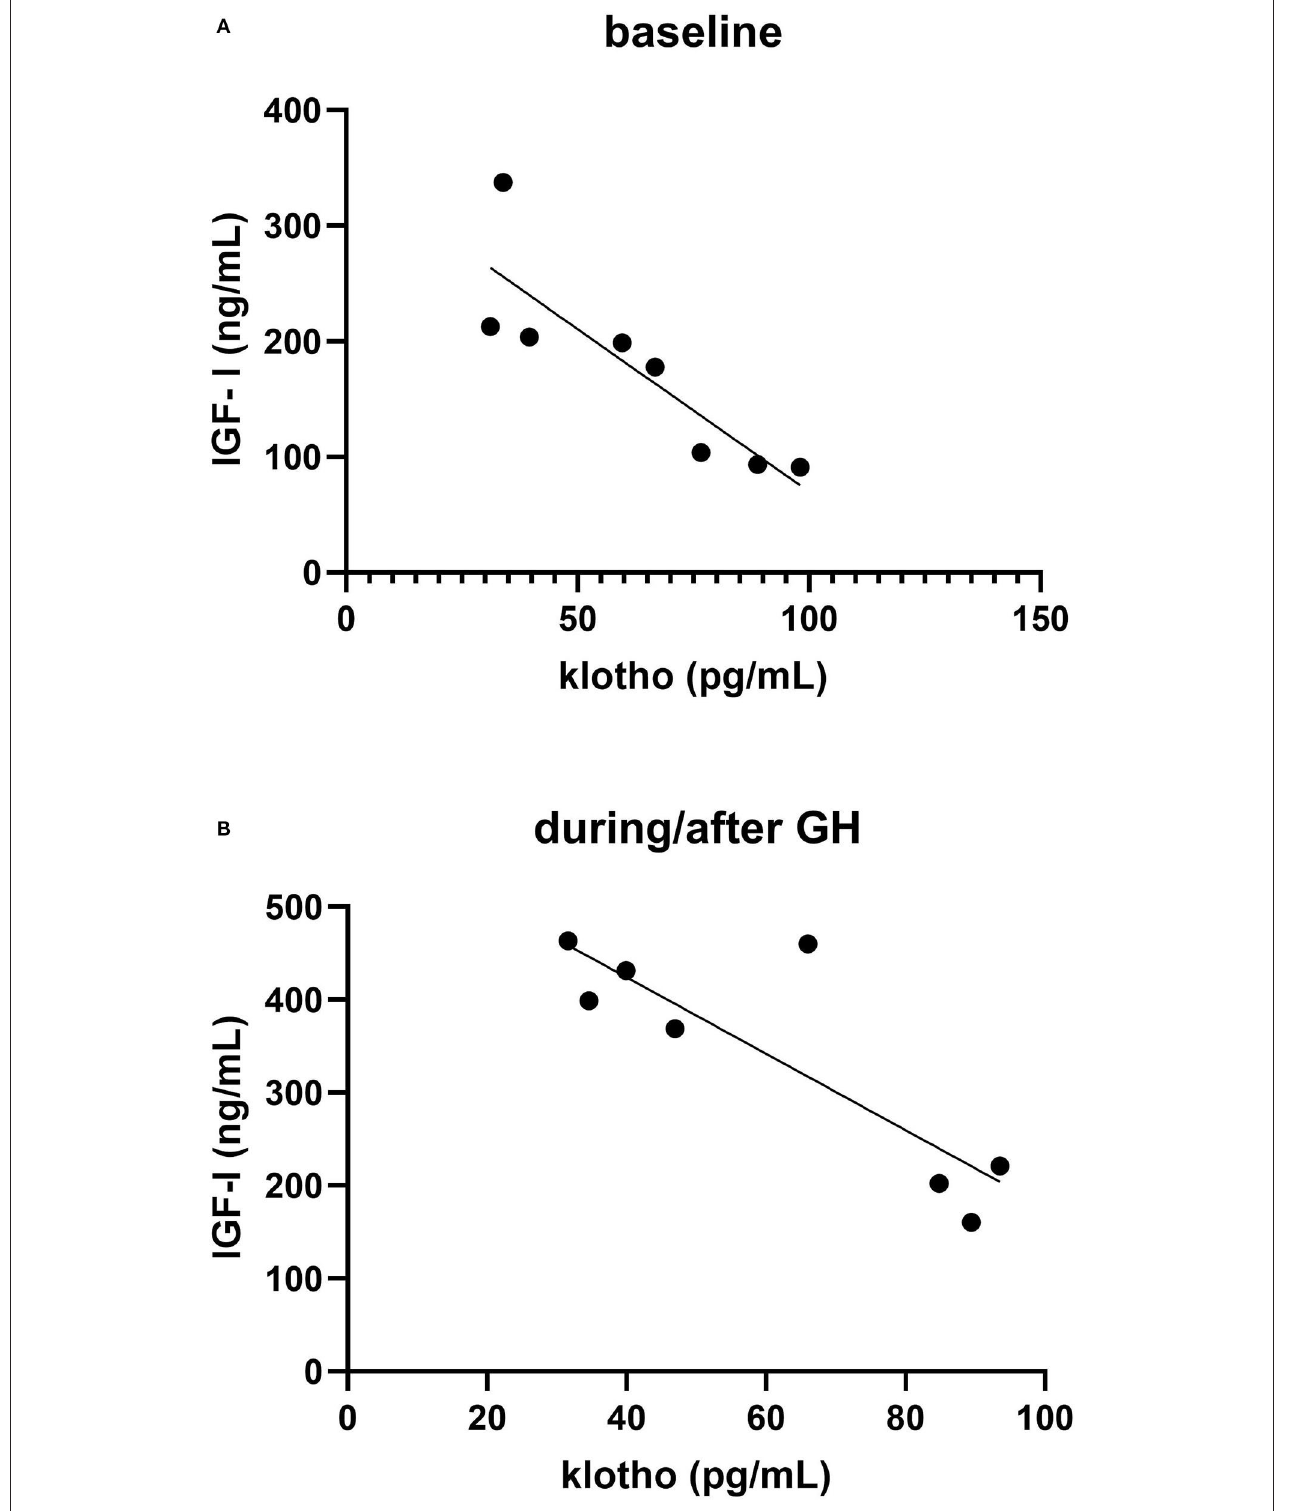
FIGURE 3 | Correlation between IGF-I and klotho in eight healthy volunteers (A) mean of three baseline values (B) mean of four samples taken during (day 7 and 13) and after ( + 3 and 24h) recombinant growth hormone (recGH) administration.